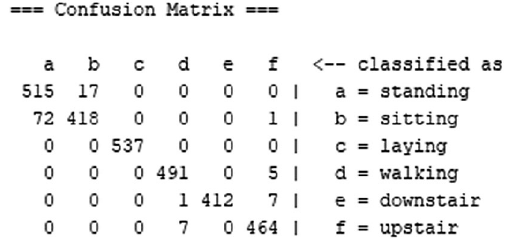
Figure 4. Confusion matrix of Stacked Discriminant Feature Learning (SDFL).